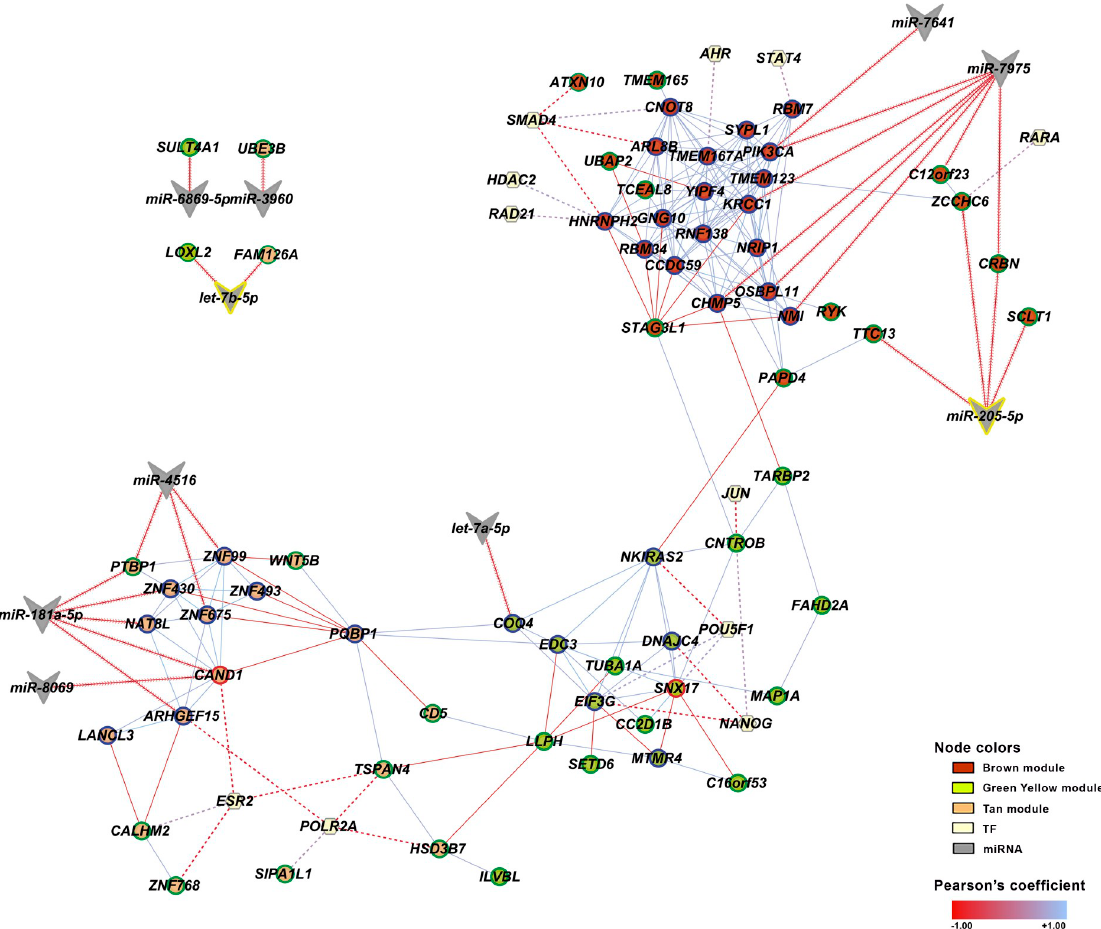
Fig 5. Integrative TF-miRNA-mRNA co-expression subnetwork of the abundantly expressed miRNAs covarying with hubs, HGS genes, and transcription factors (TFs). Nodes corresponding to hubs or HGS genes are depicted by their respective module color. Only co-expression covariance values of � |0.70| between gene-gene (solid lines), � -0.50 between gene-miRNA (arrowed lines), and � |0.50| gene-TFs (dashed lines) were considered. Positive (blue) and negative (red) co-expression interactions are depicted by a color gradient based on Pearson’s coefficient values. Abundantly expressed miRNAs are depicted by vees; abundantly expressed and DE miRNAs are highlighted with a yellow border; HGS genes are depicted by green border nodes; hubs are depicted by blue border nodes; the two HGS genes that are also a hub gene are depicted by red border nodes. TFs are depicted by hexagons.